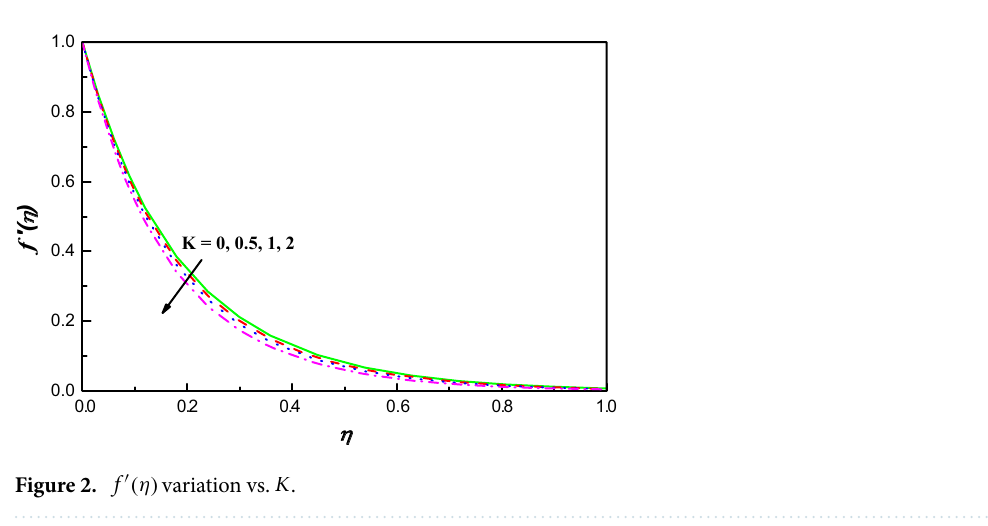
Figure 2. f ′ (η) variation vs. K